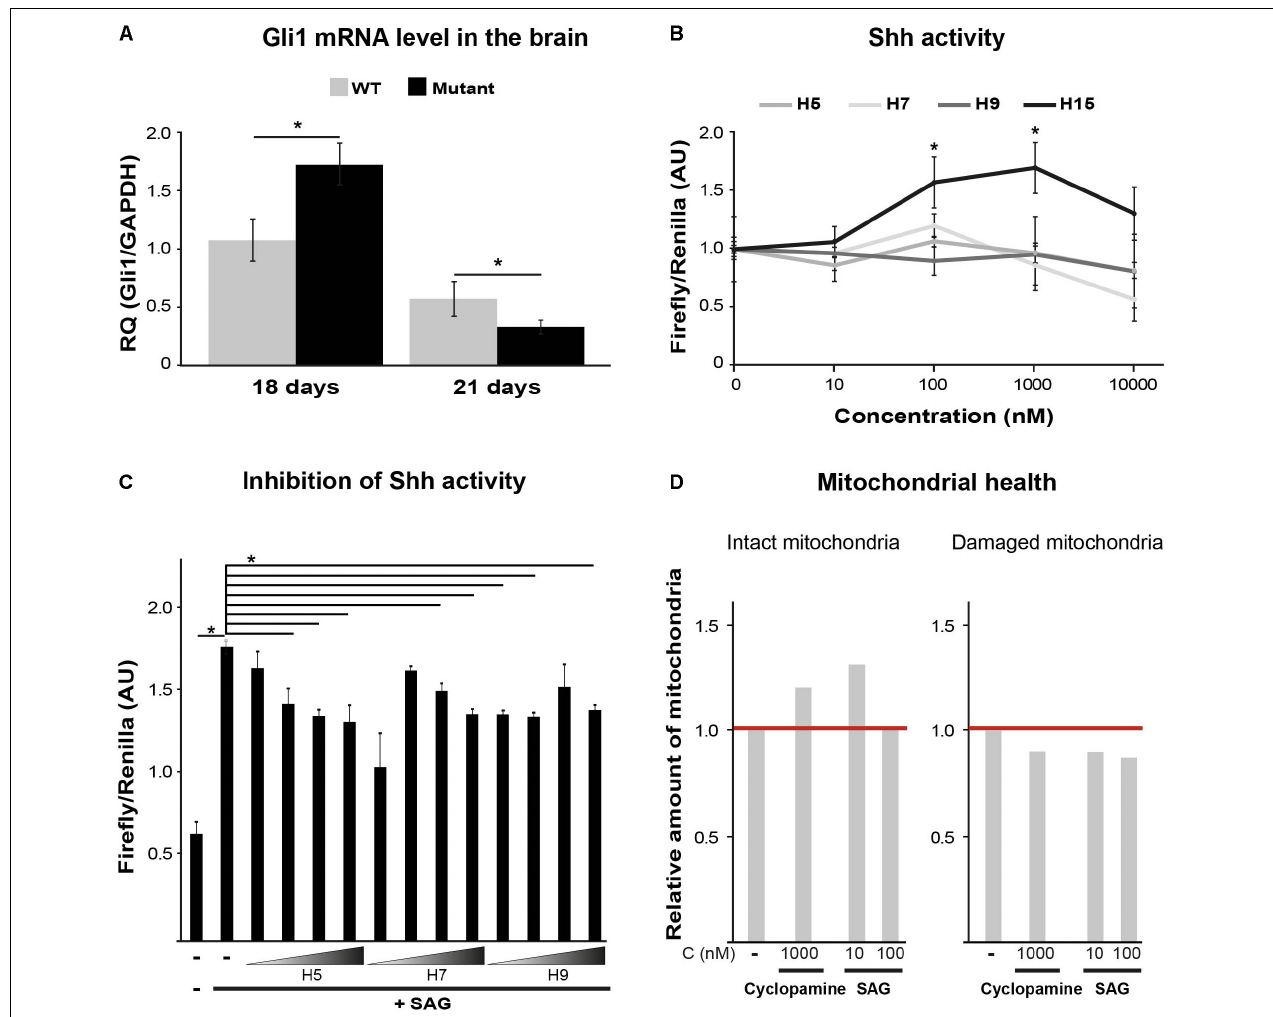
FIGURE 2 | Shh pathway target validation. (A) RT-qPCR of Gli1mRNA using total RNA extracted from the left hemisphere of p18 and p21 WT and Mutant mice brains. Shown is relative quantity (RQ) of Gli1/Gapdh following (cid:49)(cid:49) CT analysis ± SD. ∗ p < 0.02. (B) Shh activity assayed in Shh-lightII cells incubated or not for 24 h with the indicated compounds at the indicated concentrations. Shown is Firefly/Renilla luciferase activity compared to untreated cells ± SD. ∗ p < 0.015. (C) Shh activity assayed in Shh-lightII cells incubated or not for 24 h with 0.01, 0.1, 1, and 10 µ M of the indicated compounds in the presence of the Shh activator SAG at 50 nM. Shown is average Firefly/Renilla luciferase activity compared to SAG-treated cells ± SD. ∗ p < 0.04. (D) Mut MEFs incubated or not for 24 h with the indicated compounds, followed by Hoechst and JC1 staining and analysis for intact and damaged mitochondria as described in Figure 1C